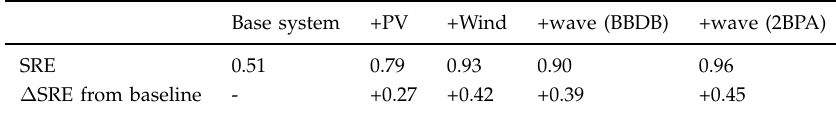
TABLE V A VERAGE SRE AMONG SIMULATIONS (2- WEEK PERIOD